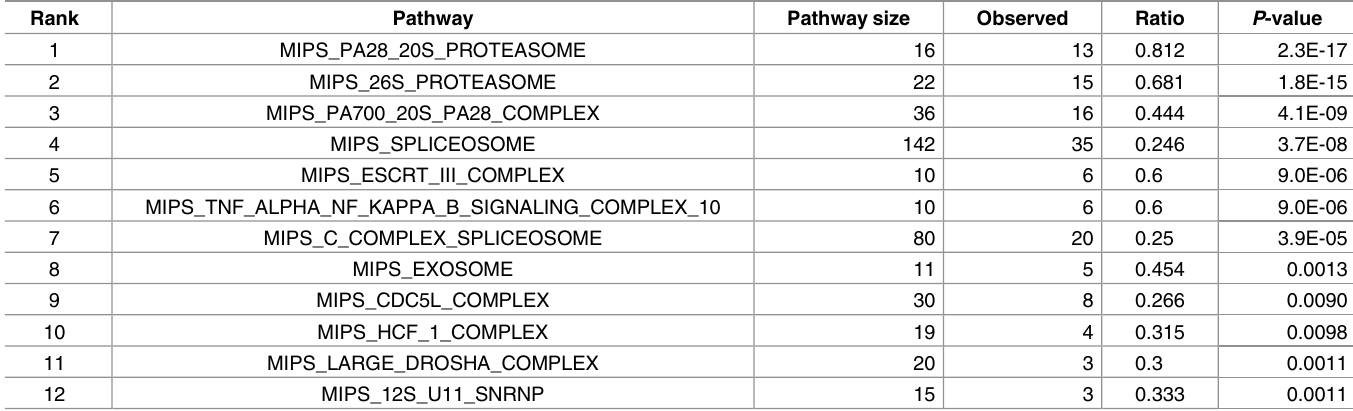
Table 4. Top-ranked pathways by MIPS